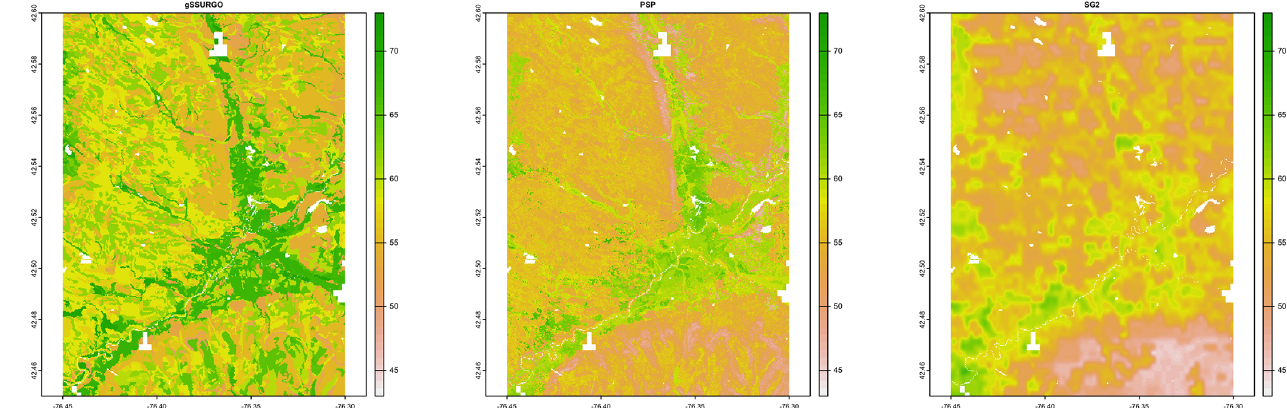
Figure 21. Topsoil (0–5cm) for pH × 10, according to the gSSURGO and DSM products. See the text for a discussion.